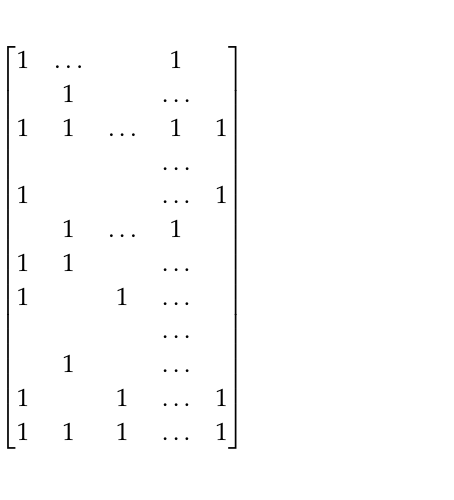
Table 1. Seven schemes of mutation matrix B calculation. QUATRE: QUasi-Affine TRansformation Evolutionary